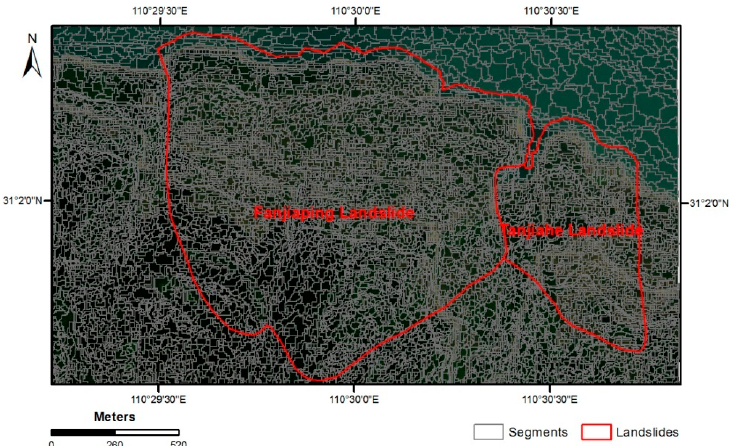
Figure 4. True color composite (R: 3, G: 2, B: 1) image overlaid by the segments; colors may not be apparent due to the density of the details: examples of the Fanjiaping and Tanjiahe Landslides.